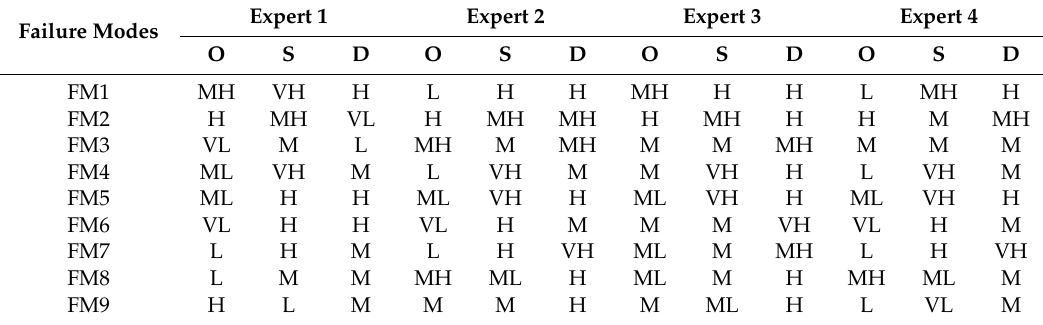
Table 6. Initial decision matrix (by each expert’s opinion).